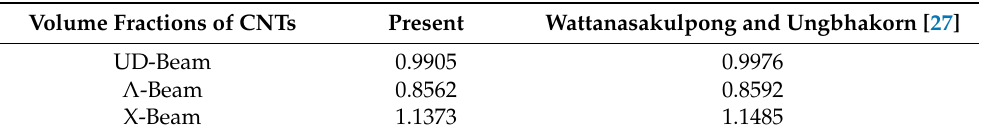
Table 3. Comparative results for dimensionless fundamental frequencies of a simply supported CNTRC beam for L/h = 15, V CNT = 0.12.